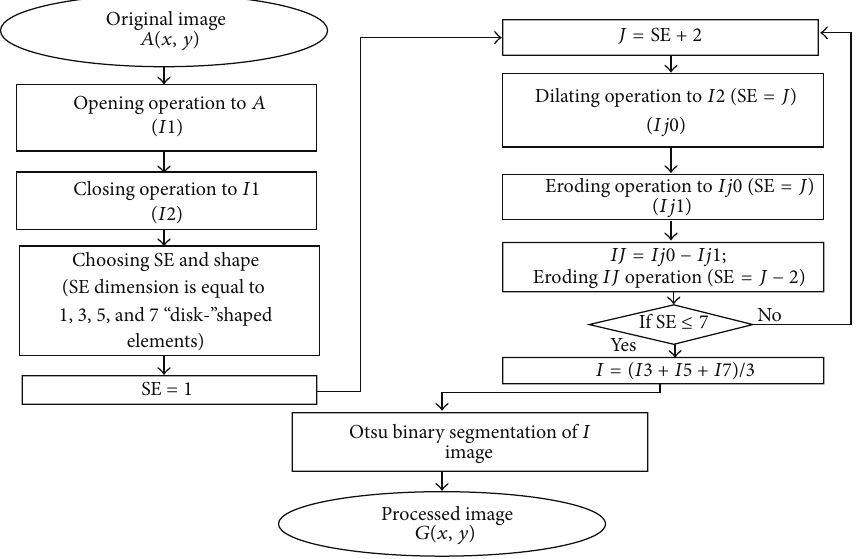
Figure 8: Flowchart applying “MNSMO” method to implement CT concrete image